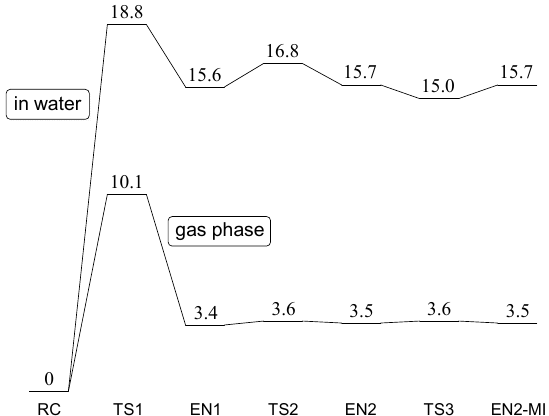
Figure 2. Energy profiles in the gas phase and in water. RC: reactant complex; TS: transition state; EN: enol; MI: mirror image. Relative energies with respect to the reactant complex (RC) are shown in kcal·mol − 1 (1 cal = 4.184 J).